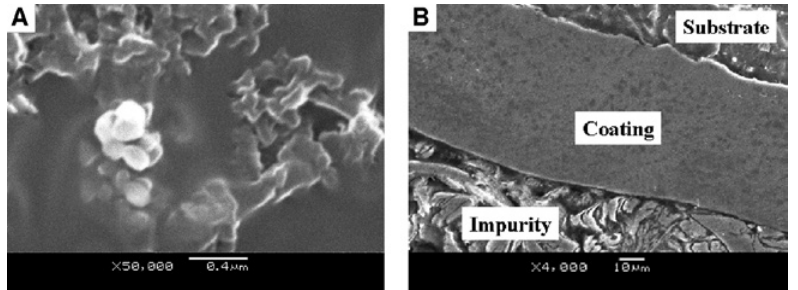
Figure 2: Morphology of TiN nanoparticles and Ni-TiN coating: (A) TiN nanoparticles, (B) Ni-TiN